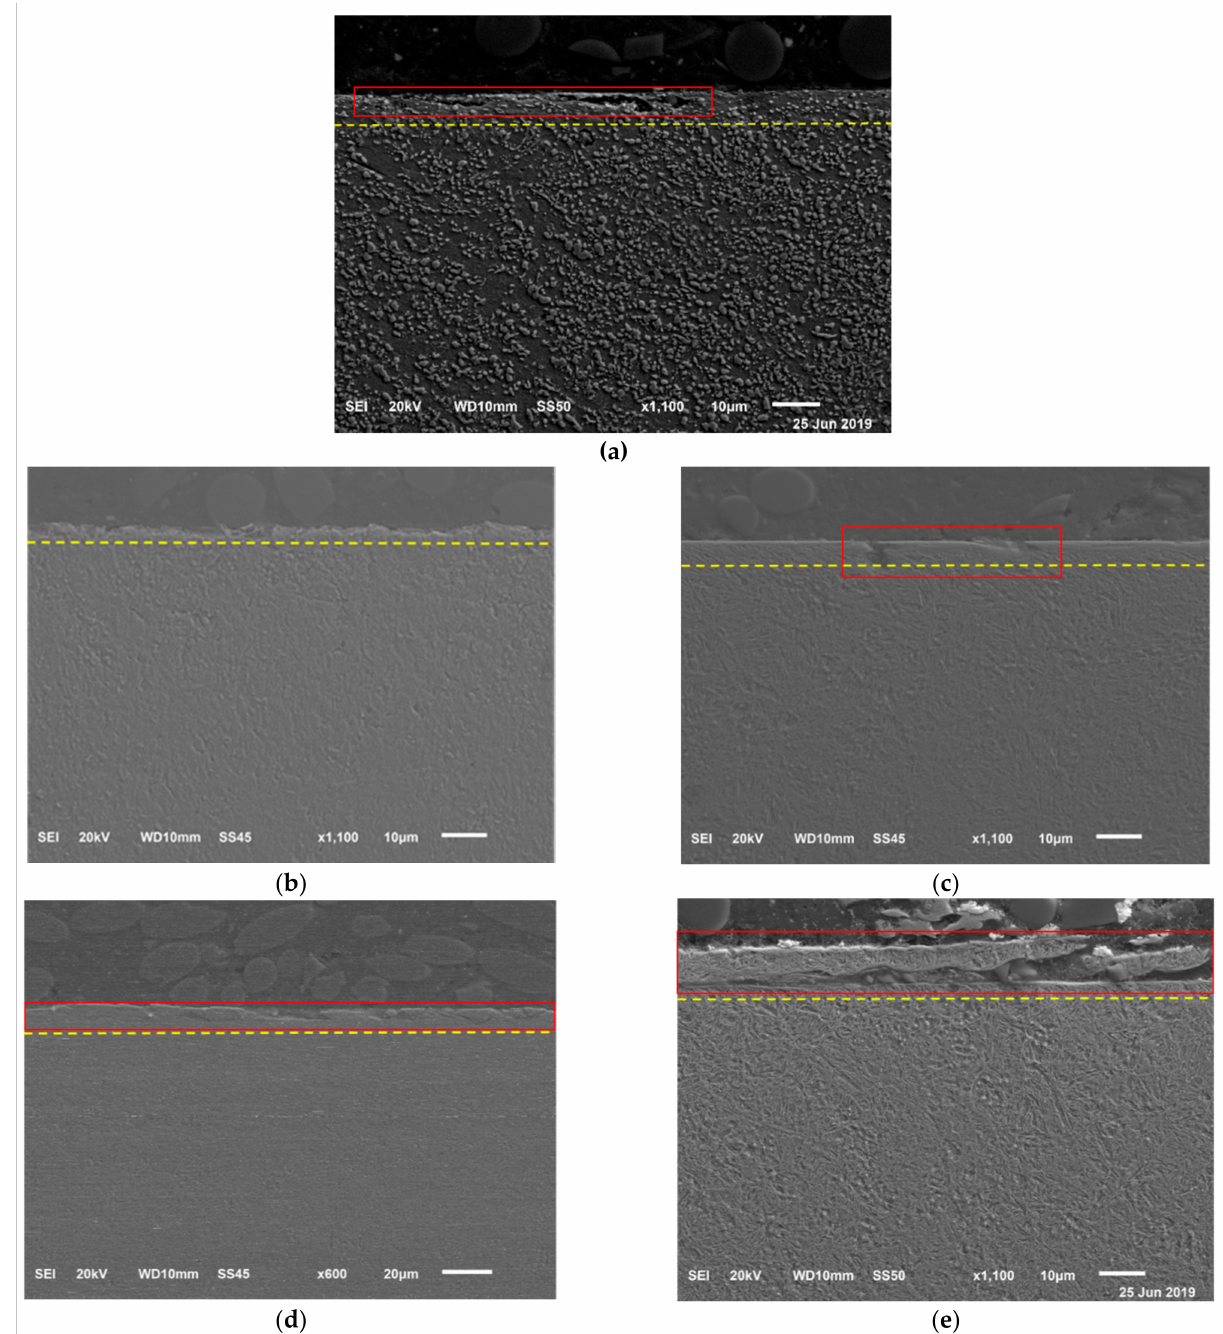
Figure 10. SEM observations on the cross-sections of ( a ) as received disks, ( b ) 288 ◦ C austempered disks, ( c ) 380 ◦ C quenched-tempered disks, ( d ) 316 ◦ C austempered disks, and ( e ) 455 ◦ C quenched-tempered disks. The red lines indicate cracks and the yellow line indicates the plastic deformation